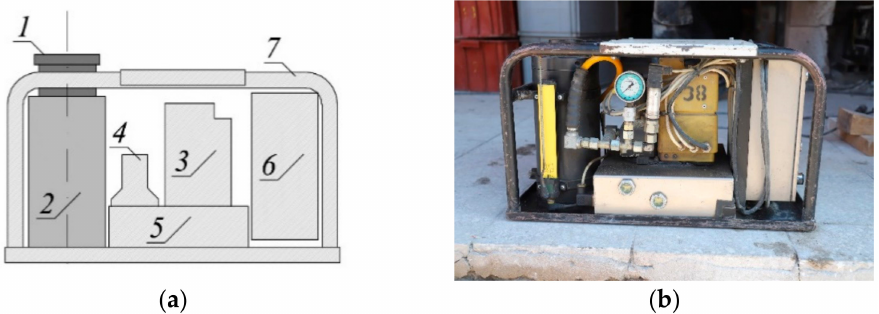
Figure 5. Hydraulic jack: ( a ) scheme; ( b ) view: 1—piston, 2—cylinder, 3—oil pump, 4—solenoid valves, 5—oil tank, 6 — control box,